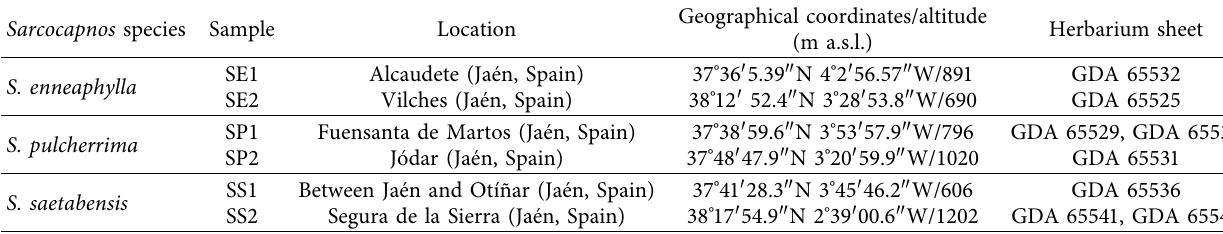
Table 1: Sarcocapnos species collected and their location.